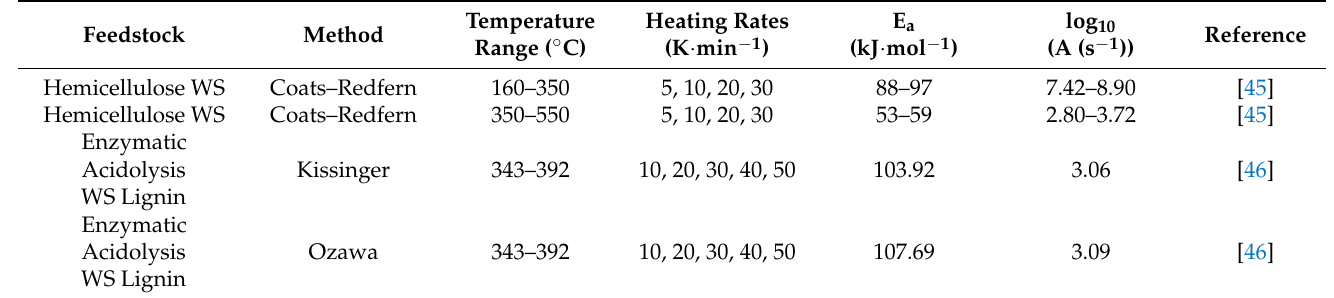
Table 3. Literature data of Arrhenius parameters for the non-catalytic degradation of wheat straw (WS)